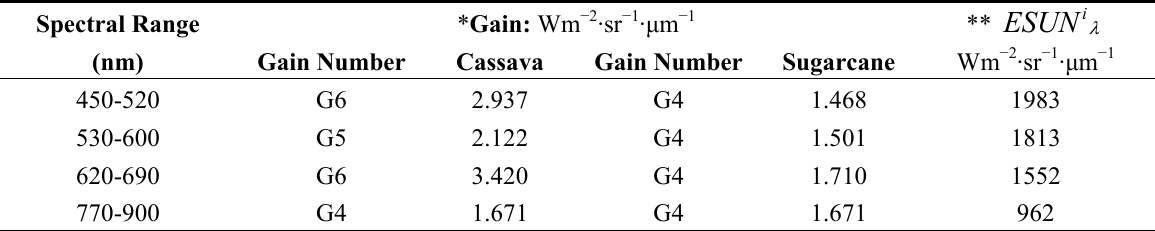
Table 3. THEOS spectral ranges, gain numbers, and mean exo-atmospheric solar irradiances ( λ i ESUN ) for cassava and sugarcane. Spectral Range